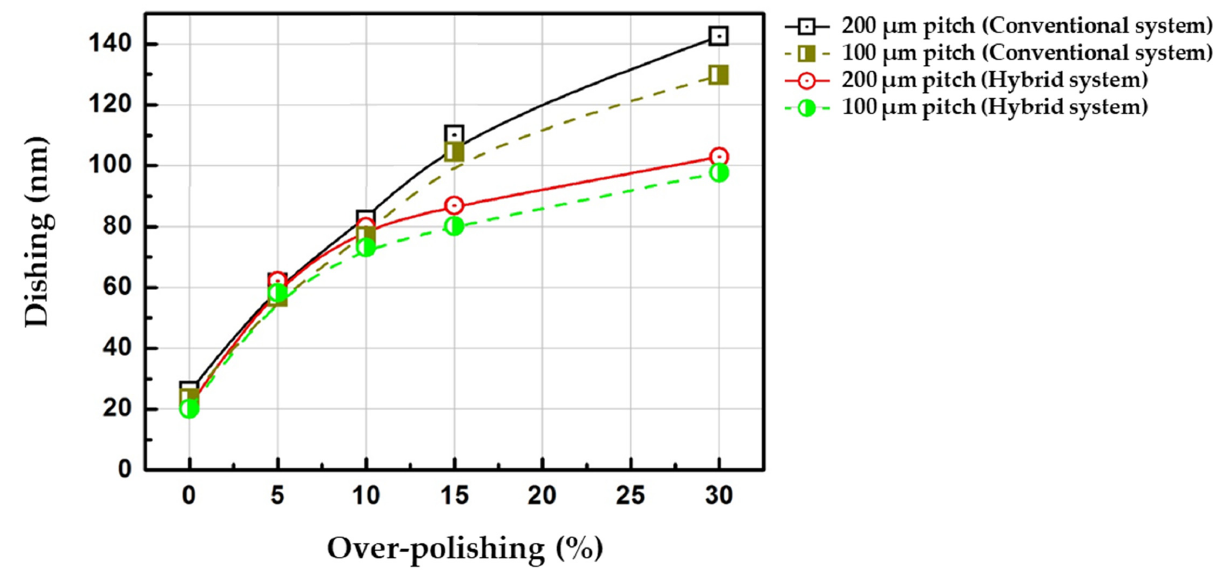
Figure 10. Cu dishing dependency on the over-polishing. The conventional and hybrid systems are compared considering different pitches.